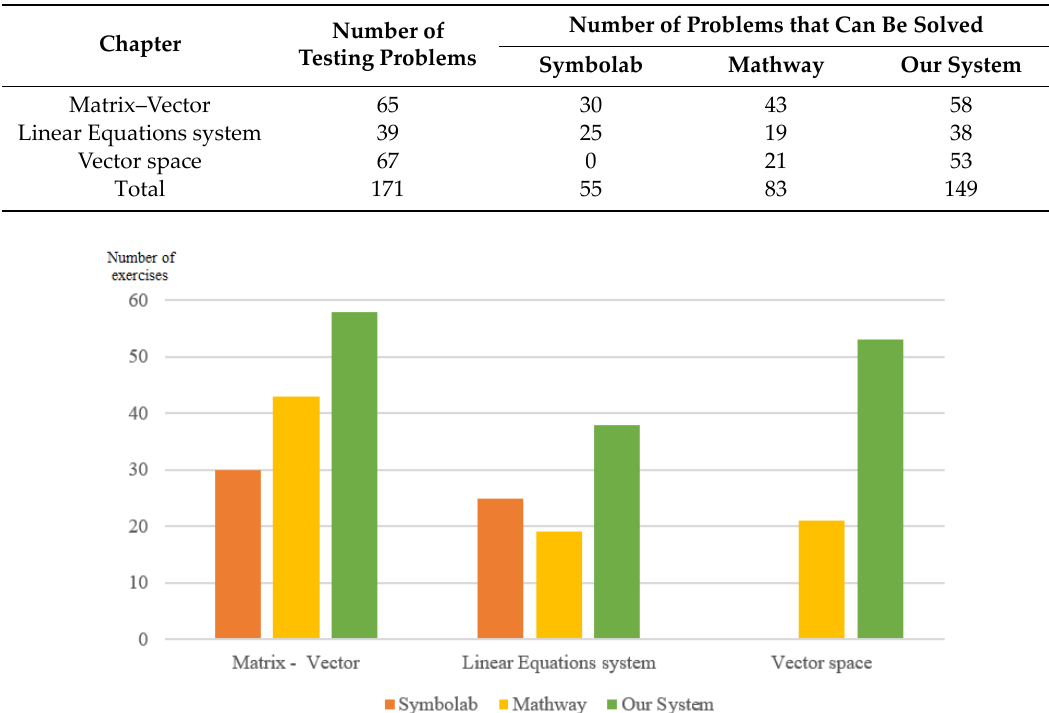
Table 4. The results of testing of exercises in [13].